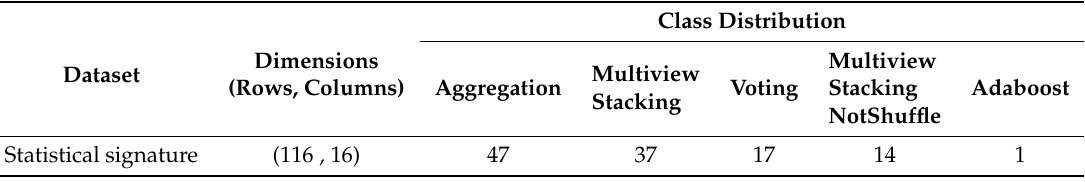
Table 11. Dimensions and class distribution of the Statistical signature data set.